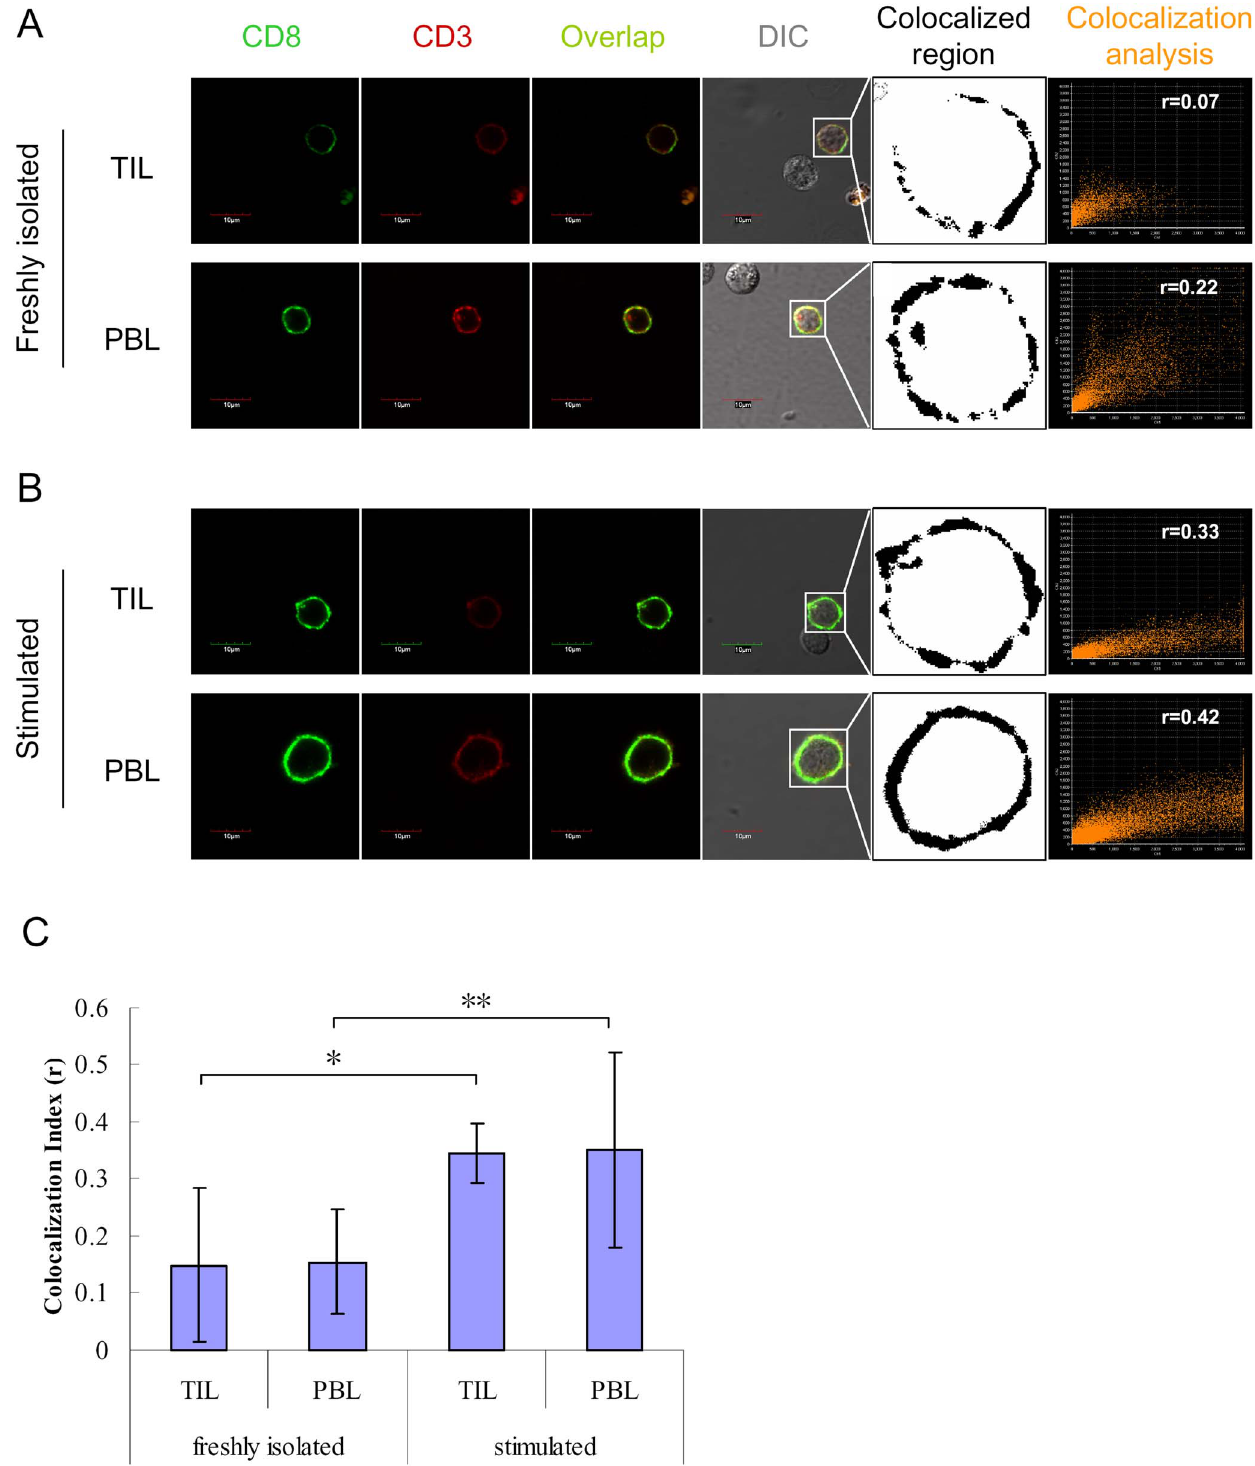
Figure 6. Colocalization analysis of CD3 and CD8 on TIL of patients and on PBL of healthy controls. TIL of cancer patients and PBL of healthy controls, either freshly isolated ( A ) or stimulated ( B ) with 1000 U/ml IFN- c (at day 0), 50 ng/ml OKT3 (at day 1) and 500 U/ml IL-2 (from day 1 onward to day 6), were separately incubated with mAbs, CD8-FITC and CD3-PC5. The cells were observed with a confocal laser scanning microscope. The colocalization of CD3 and CD8 was analyzed, and colocalization index (r) was calculated by FV10-ASW2.1 software. For each group, 30 different cells from 3 individual were used for calculating the colocalization index ( C ). * P , 0.05; ** P , 0.01, unpaired 2-tailed Student’s t test.